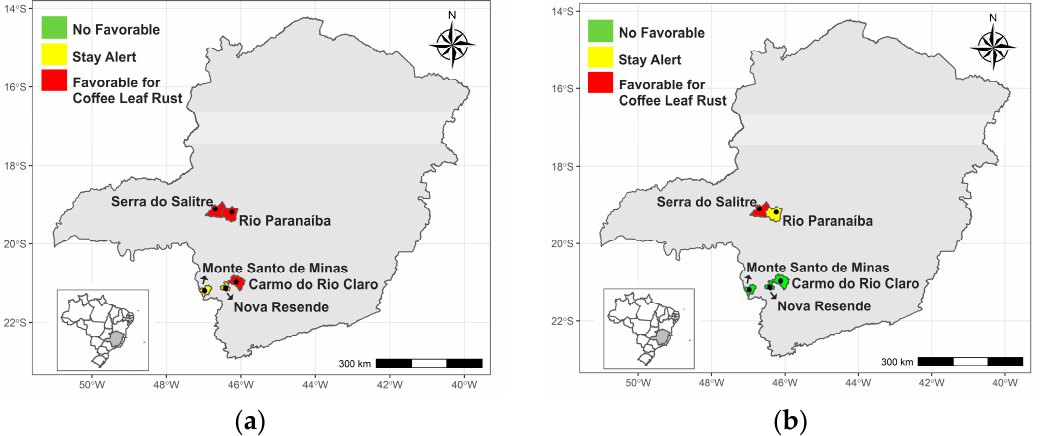
Figure 2. Interface for viewing the phytosanitary warning in the municipalities of Carmo do Rio Claro, Monte Santo de Minas, Nova Resende, Rio Paranaíba and Serra do Salitre in the state of Minas Gerais, Brazil: ( a ) DSS 1; ( b ) DSS 2.